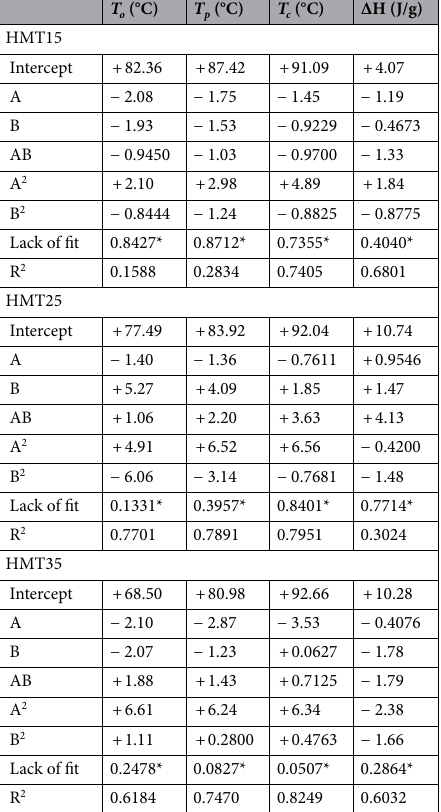
Table 9. Regression models relating gelatinization parameters and model parameters of heat-moisture treated Bambara groundnut starch. A: linear effect of treatment temperature ; B: linear effect of treatment time ; AB : interaction of temperature and treatment time ; A 2 : quadratic effect of treatment temperature ; B 2 : quadratic effect of treatment time; T o : onset temperature; T p : peak temperature; T c : conclusion temperature; ∆H: gelatinization enthalpy. *Not significant at p ≥